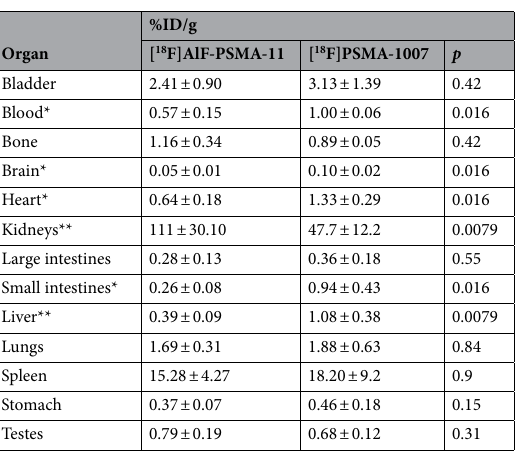
Table 2. Biodistribution data of [ 18 F]AlF-PSMA-11 and [ 18 F]PSMA-1007 of healthy organs. The values represent the percentage injected dose per gram tissue weight 1 h after injection. %ID/g = percentage injected dose per